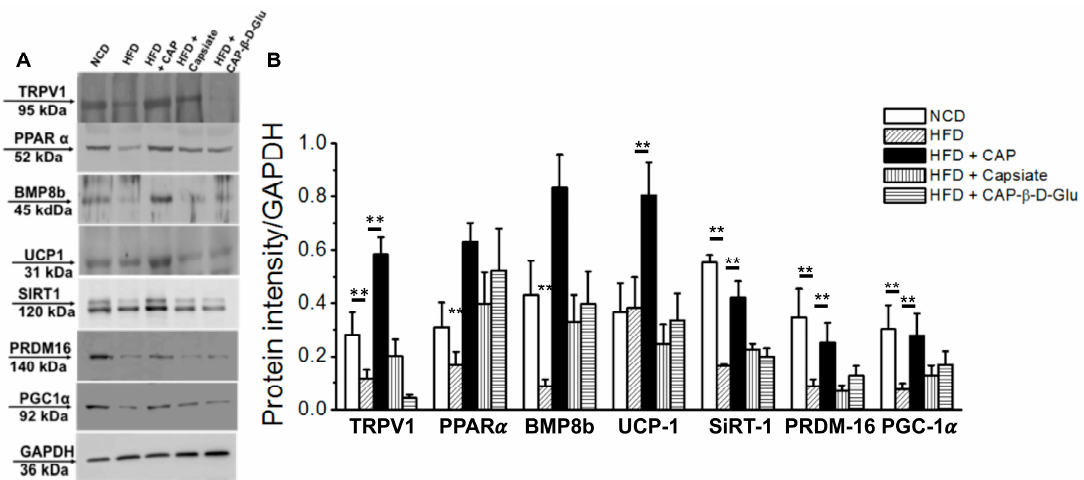
Figure 4. Effect of CAP, Capsiate, and CAP- β - D gluco on thermogenic protein. A . Representative western blots showing the expression Of TRPV1, PPAR α , BMP8b, UCP-1, SiRT-1, PRDM-16, and PGC-1 α in the inguinal WAT of NCD or HFD ( ± CAP, Capsiate or CAP- β - D gluco)-fed wild type mice. B . Mean protein intensities ± SEM for n = 3 experiments/condition. ** represent statistical significance for p < 0.05.